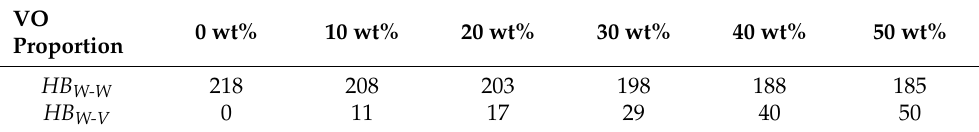
Table 7. The average number of different types of hydrogen bonds at 3 wt% water content.